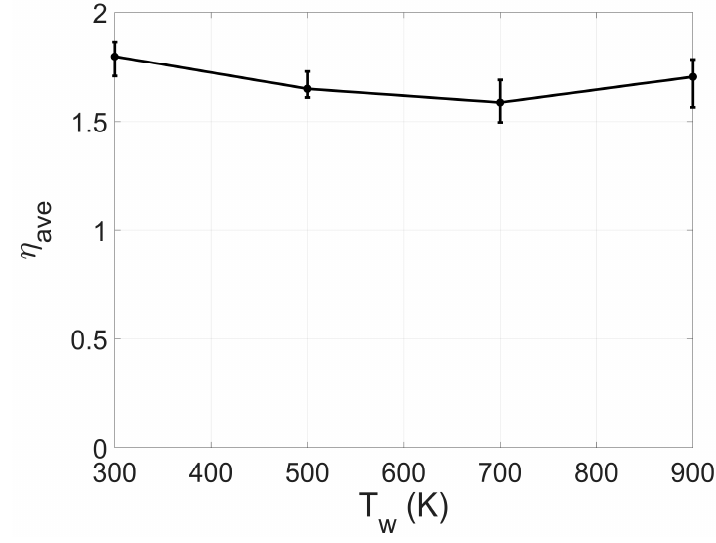
Figure 5. Average friction factor vs. workpiece temperature.